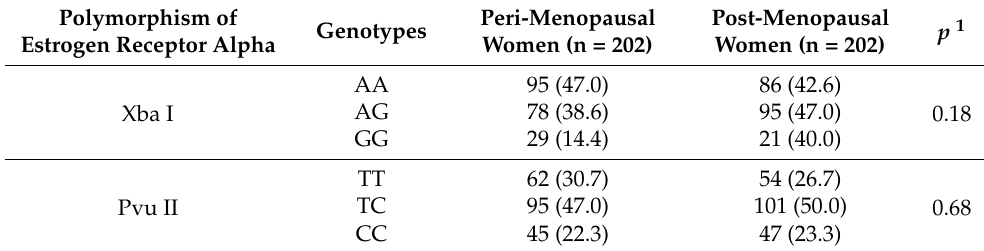
Table 1. Polymorphism of estrogen receptor alpha: Xba I and Pvu II in peri- and post- menopausal women. Polymorphism of Genotypes Estrogen Receptor Alpha